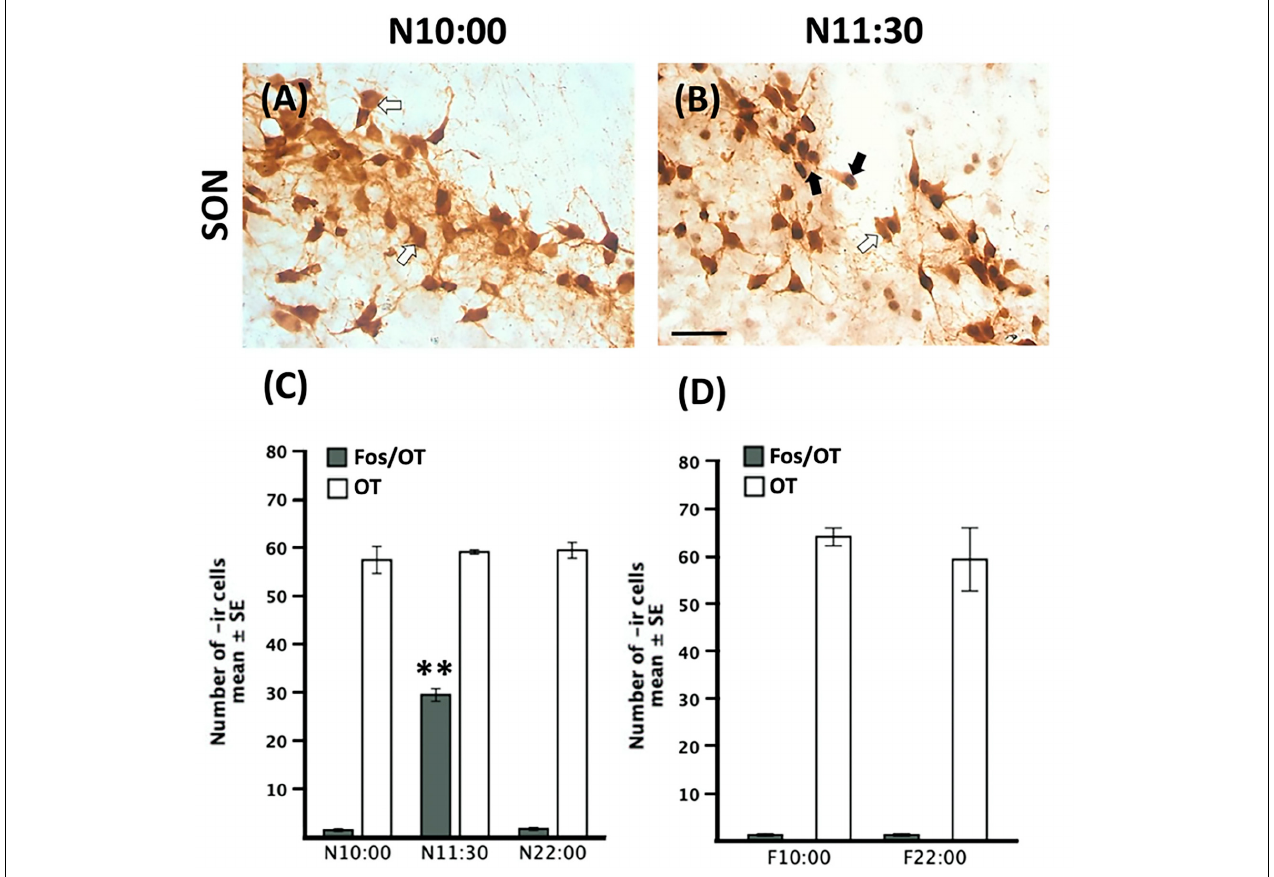
FIGURE 6 | Increase of Fos-/OT-ir cells after nursing in the SON. Representative photomicrographs of the SON just before (N10:00, A ) and after (N11:30, B ) nursing. (C,D) Quantitative analysis of OT- and Fos-/OT-ir cells in nursed (C) and fasted subjects (D) . White arrow, OT-ir; black arrow Fos-/OT-ir. Note the increase in double labeled cells only after food ingestion. ∗∗ P < 0.001, denotes significant difference between N11:30 and N:10:00 and N22:00 groups. Scale bar 50 µ